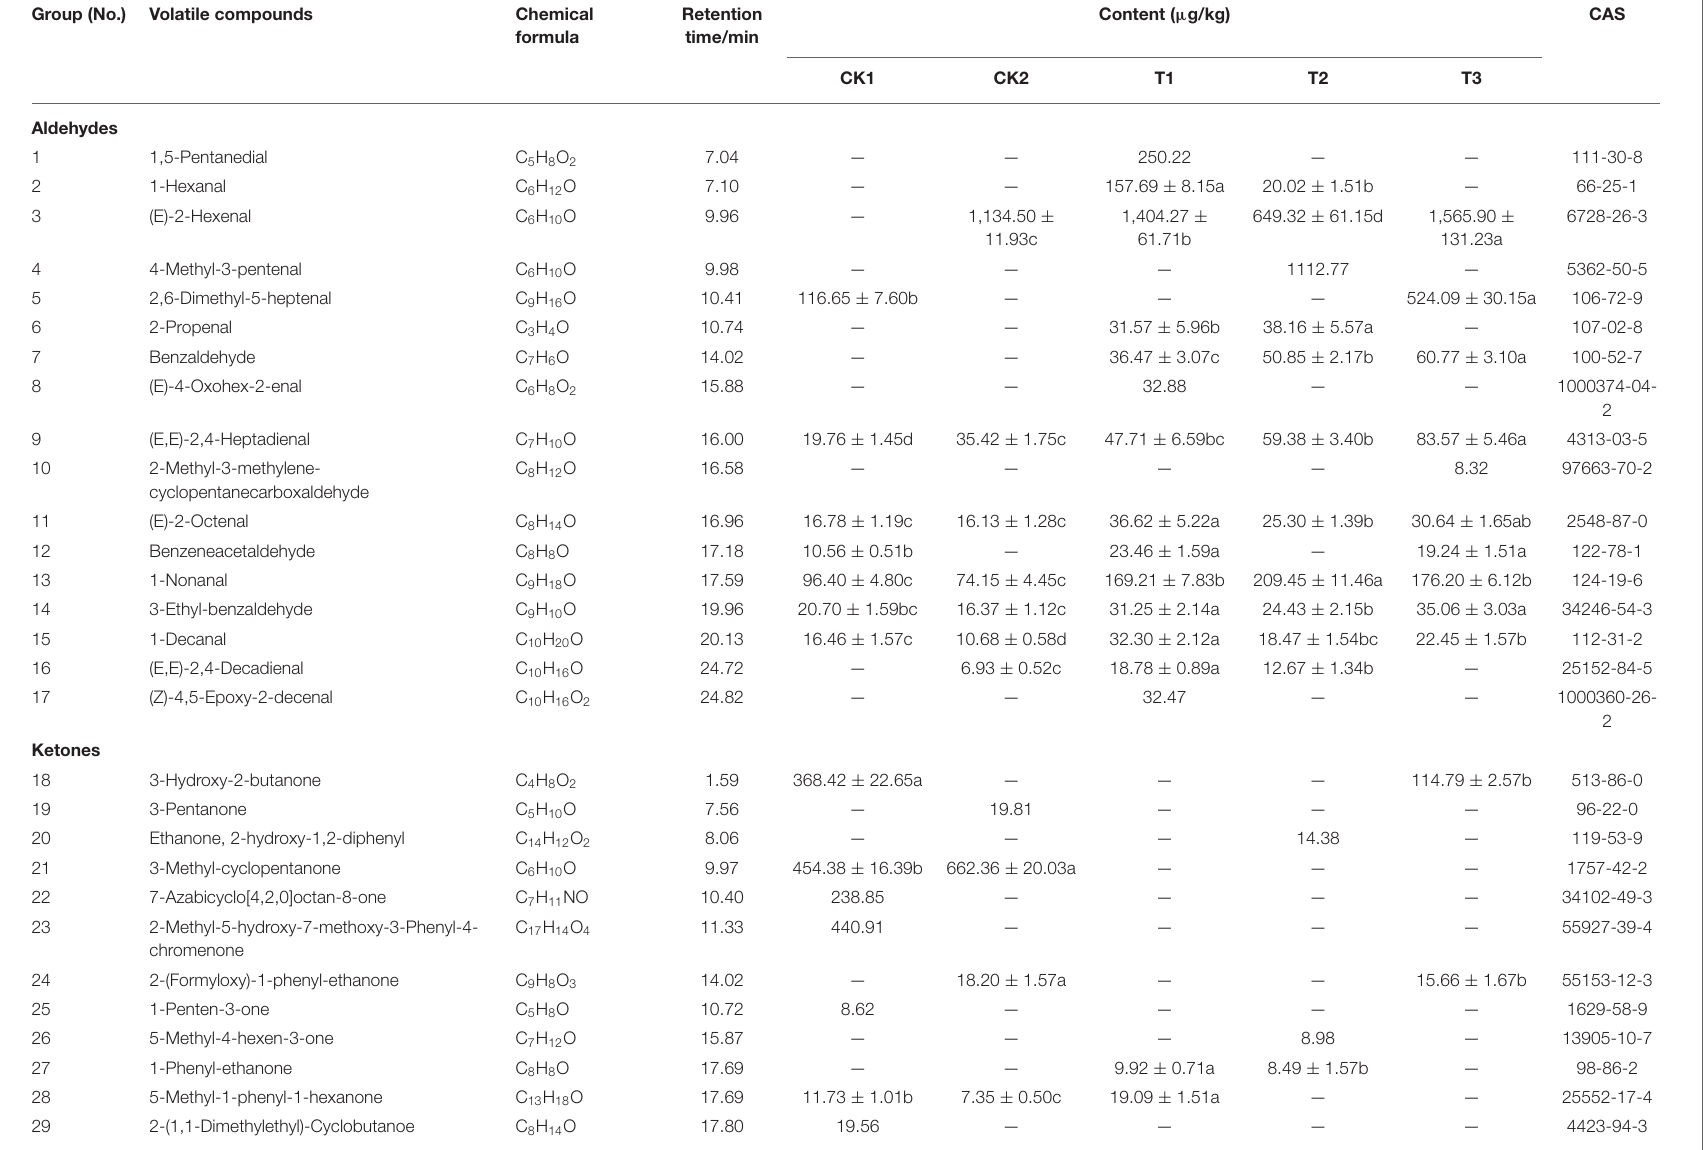
TABLE 5 | Effects of different ground mulching patterns on volatile compounds in loose-curd cauliflower heads. Group (No.) Volatile